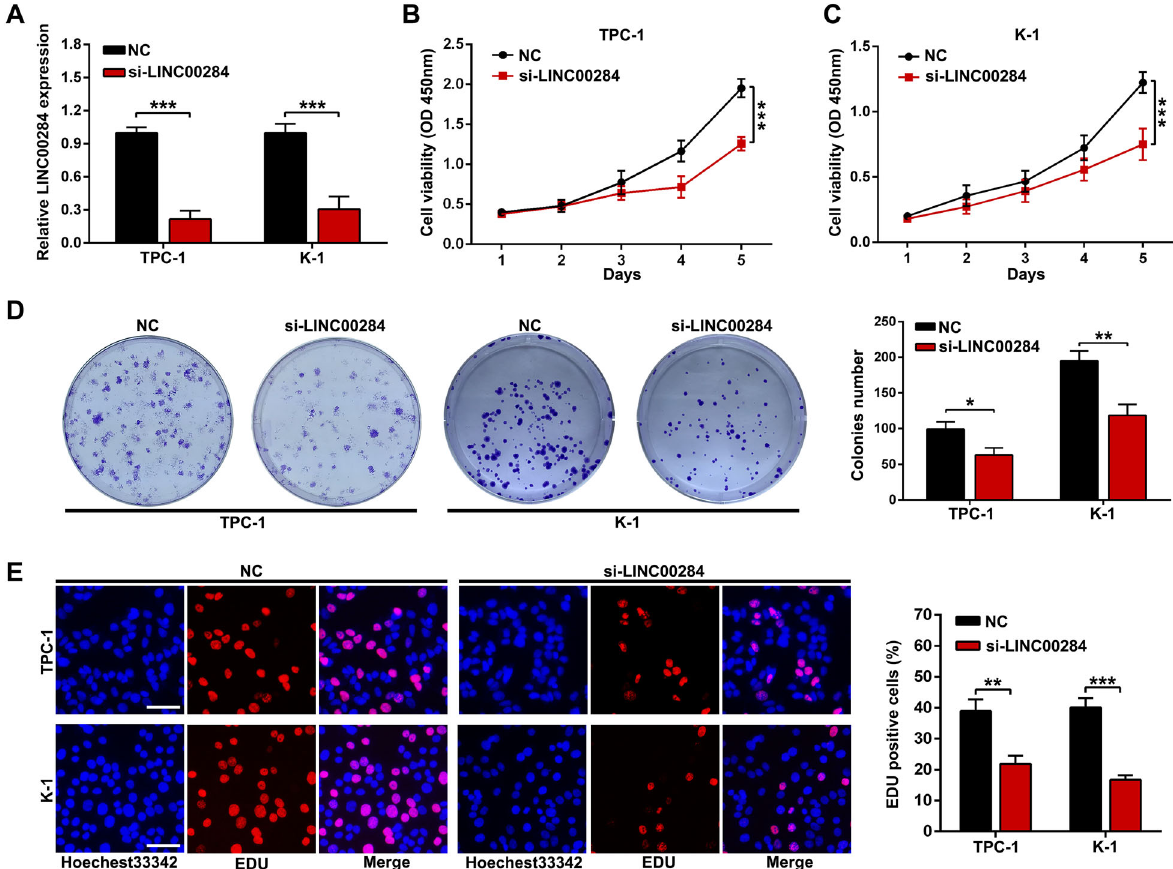
Fig. 2 Impacts of LINC00284 on PTC cell proliferation in vitro. A LINC00284 expression in TPC-1 and K-1 treated by si-LINC00284 or si-NC was detected by qRT-PCR. B CCK8 experiments were adopted to assess the viability of si-LINC00284 treated PTC cells. C Colony formation assays were used to examine the growth of PTC cells after transfection. D The proliferation ability of PTC cells transfected with si-LINC00284 was analyzed by EdU staining assays (scale bar: 100 μ m). Values indicated mean ± standard deviation. * P < 0.05, ** P < 0.01, and *** P <